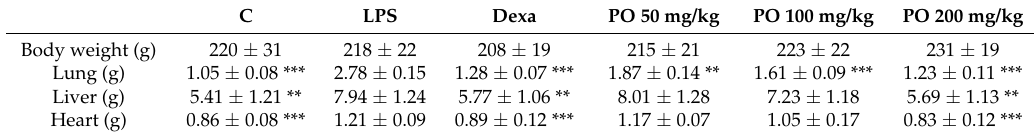
Table 1. Body and absolute organs weights for different groups.